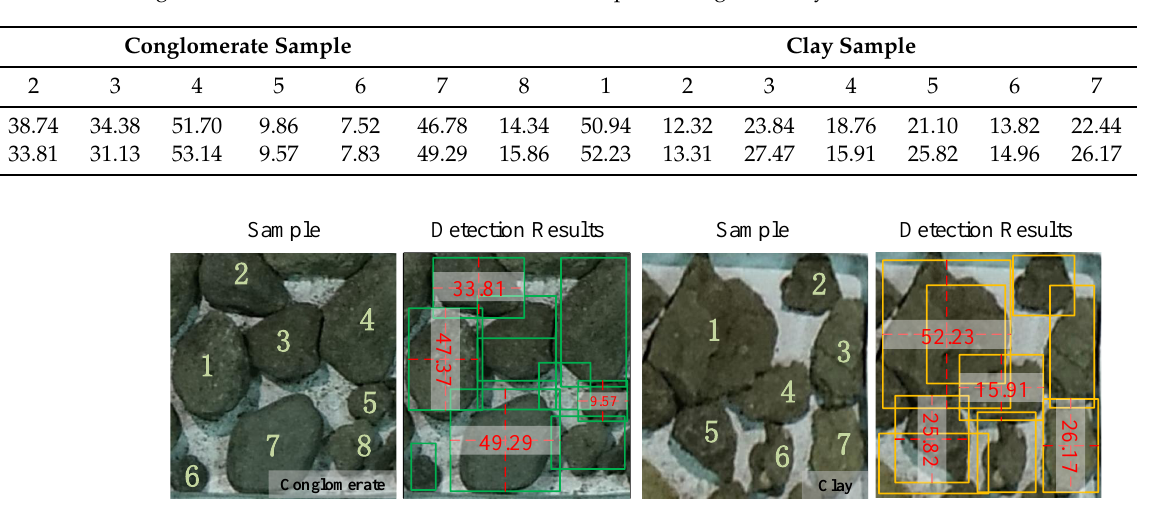
Table 6. Comparison between physical measured value and predicted value. GT represents the ground truth of the material. PG indicates the predicted granularity value.